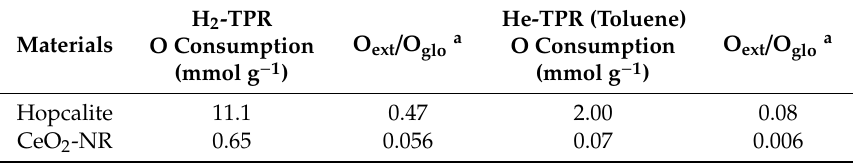
Table 5. Determination of extracted oxygen from solids in He atmosphere.